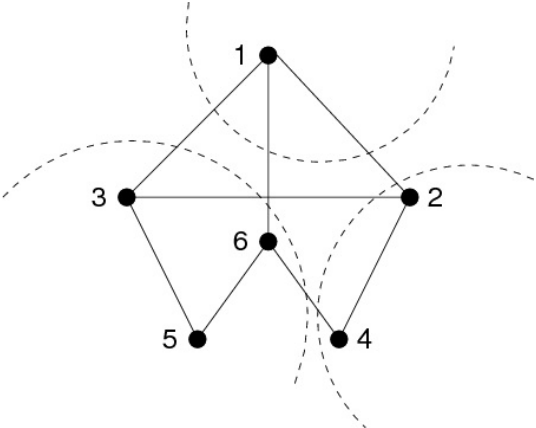
Figure 6 . MCS on a non-chordal graph. Substars of 1 : { 2 , 6 } and { 3 , 6 } . These substars are not pairwise